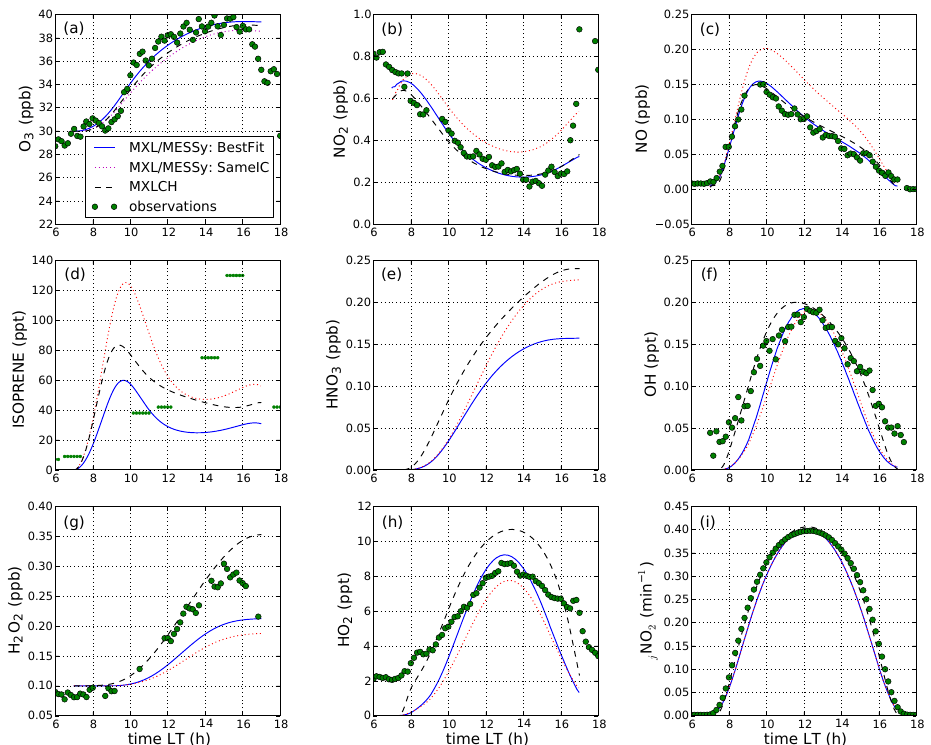
Figure 6. Observed and modelled mixed-layer mixing ratios of (a) O 3 , (b) NO 2 , (c) NO, (d) isoprene, (e) HNO 3 , (f) OH, (g) H 2 O 2 and (h) HO 2 and (i) NO 2 photolysis rate for the DOMINO case, comparing MXL/MESSy and MIM2 chemistry with MXLCH and reduced chemistry. Results for both the SameIC and the BestFit runs with MXL/MESSy are